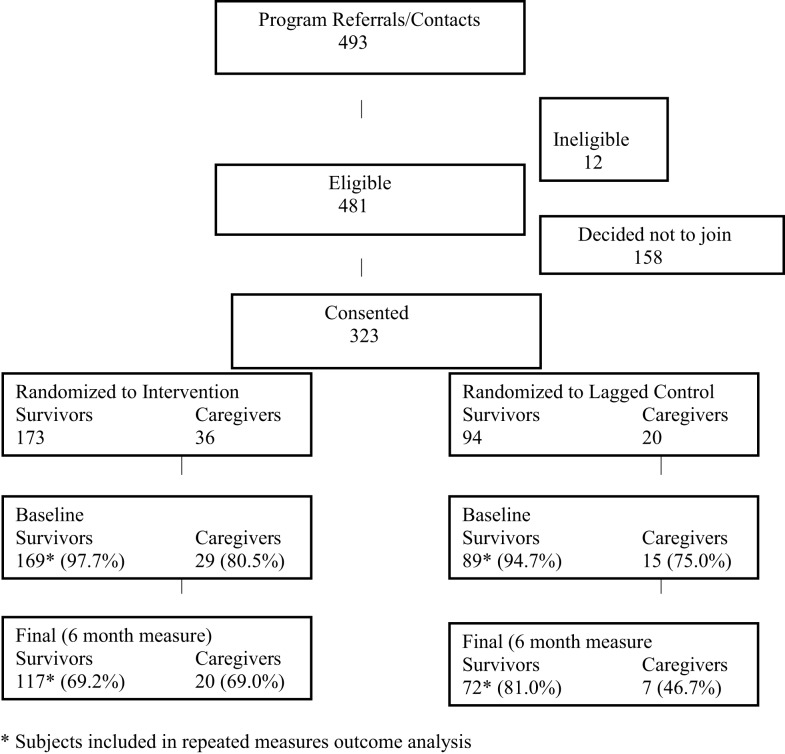
Study participation.